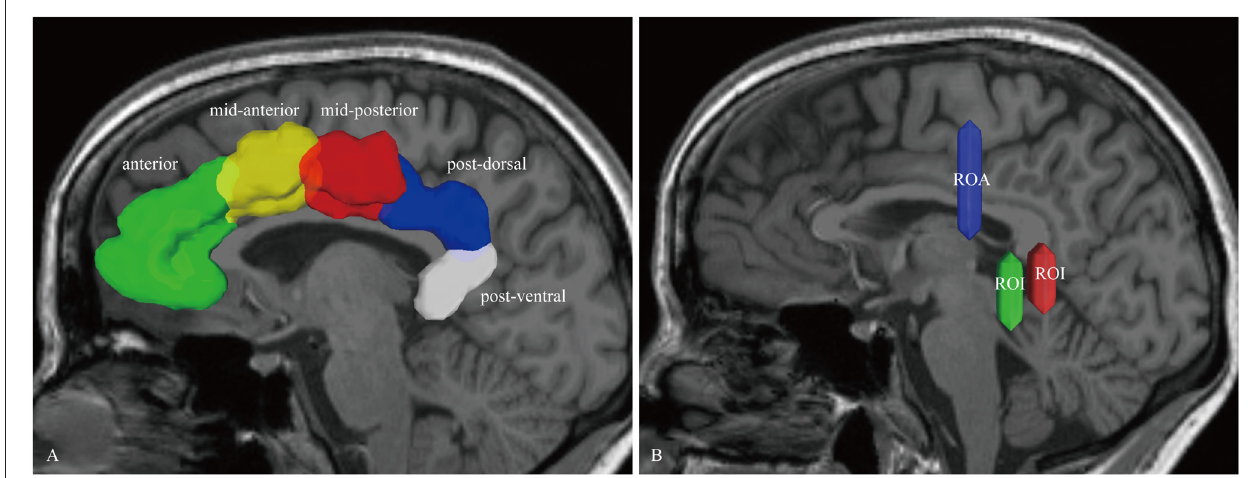
FIGURE 1 | In vivo fiber tractography of the cingulum bundle (CB). (A) The region of interests (ROIs) of the CB consist of five segments: anterior (green), mid-anterior (yellow color), mid-posterior (red color), post-dorsal (blue color) and post-ventral (white color) cingulate cortex. (B) Two ROIs and one region of avoidance (ROA) are used for reconstructing the para-hippocampal CB. The ROIs are placed behind and below the splenium. One ROA is placed above the body of the corpus callosum (CC). CB, cingulum bundle; ROI, region-of-interest; ROA, region of avoidance.